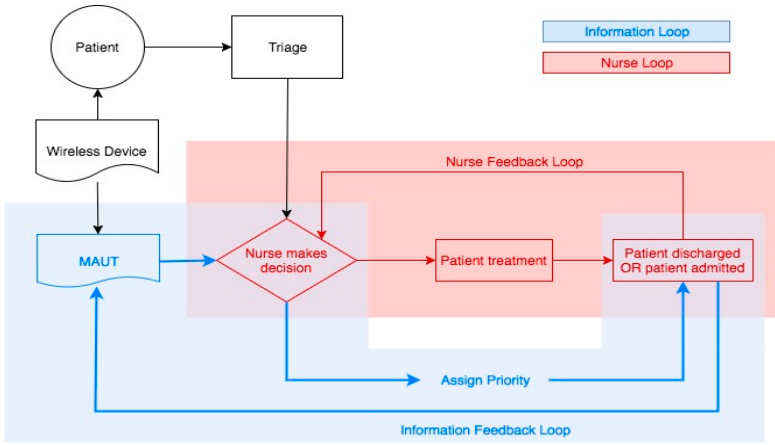
Figure 5. Proposed Nurse and Information Feedback Loops.